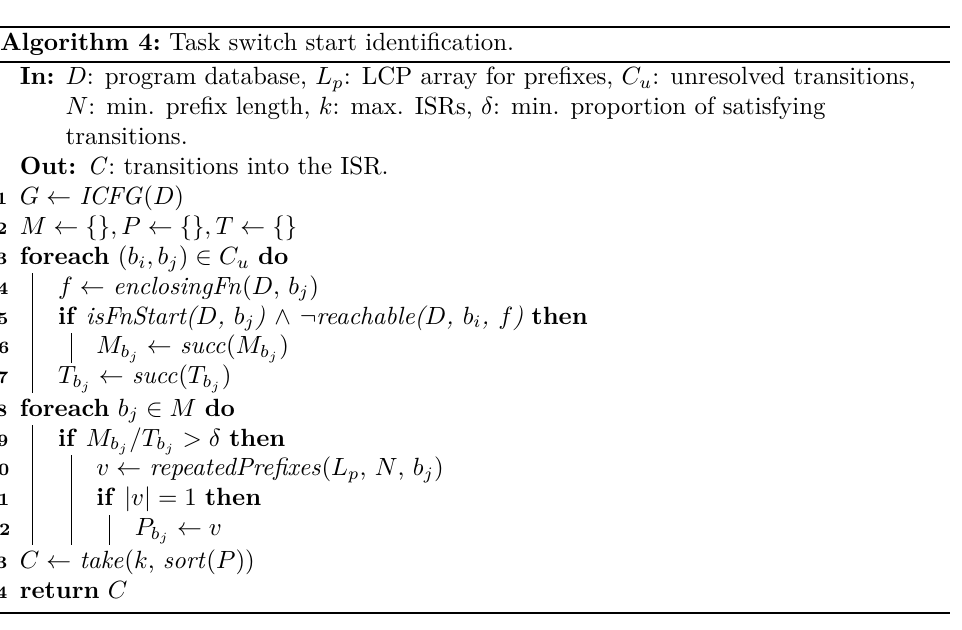
Algorithm 4: Task switch start identification.